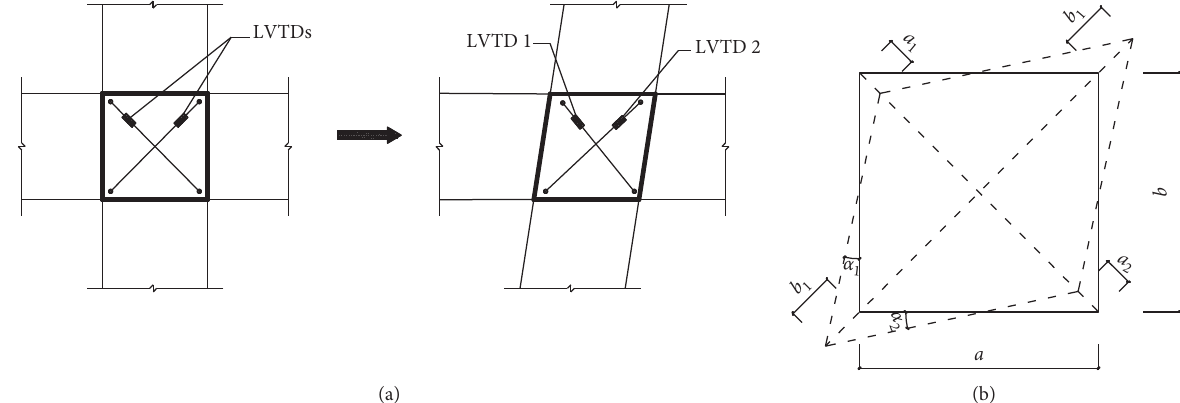
Figure 19: Core shear deformation: (a) schematic diagram of frame joint before and after deformation and (b) diagram of shear